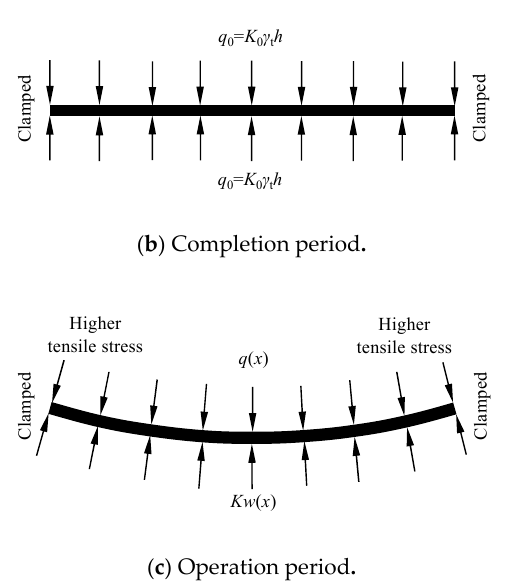
Figure 16. Mechanical diagram of SACC (completion period and operation period).